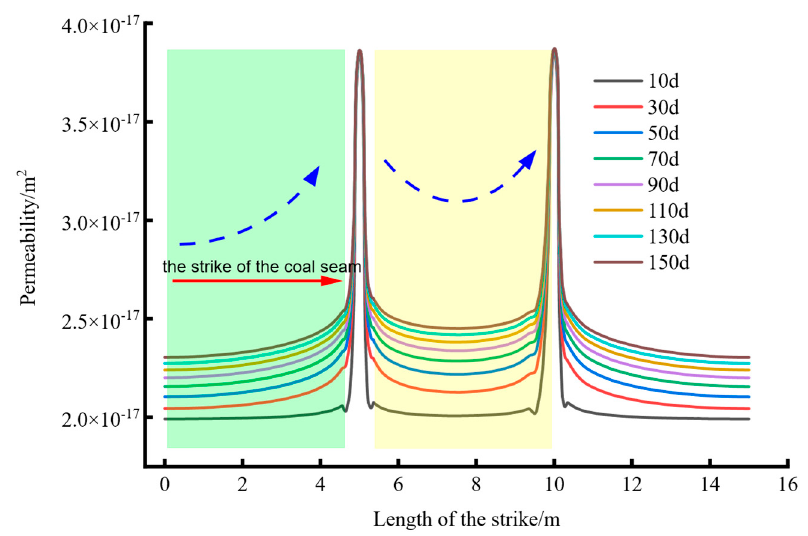
Figure 6. Permeability evolution characteristics of the coal seam along the strike. Figure 6 is divided into two sections for analysis: Area I and Area II. The permeabil-